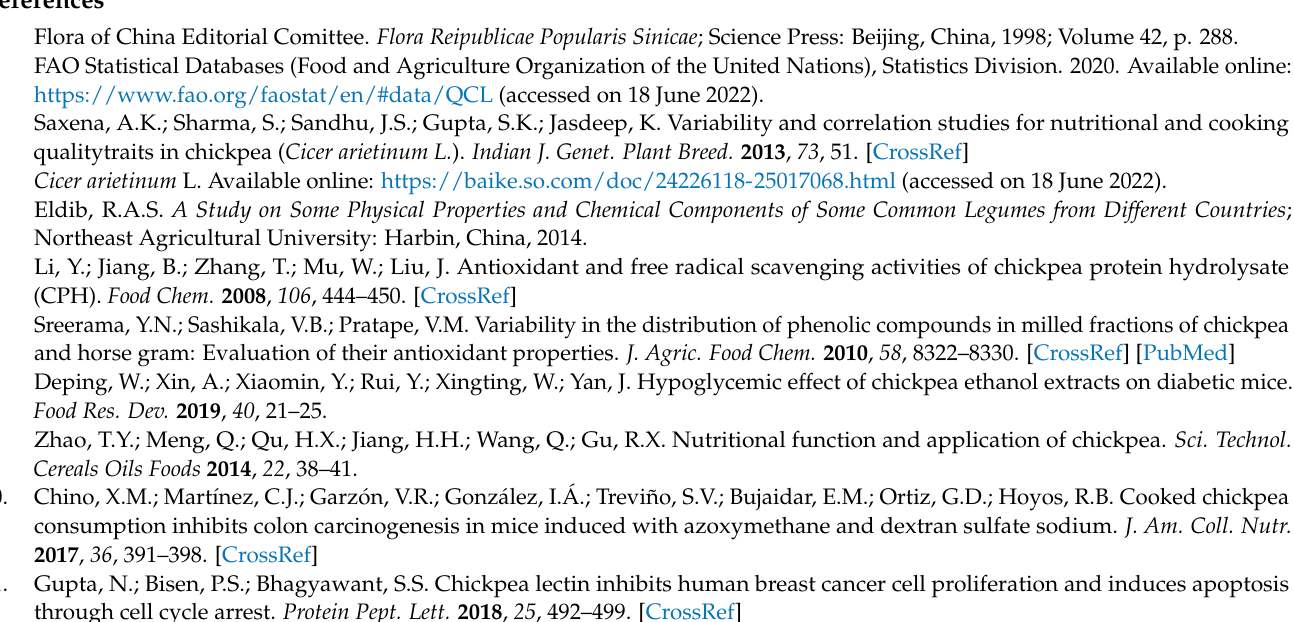
validation; Figure S4: DD vs YZD KEGG barplot; Table S1: List and characteristics of the metabolites identified and quantified in DD and YZD; Table S2: List of DAMs in the YZD vs. DD; Table S3: Statistics of DAMs between YZD and DD; Table S4: List of KEGG pathway in the YZD vs.